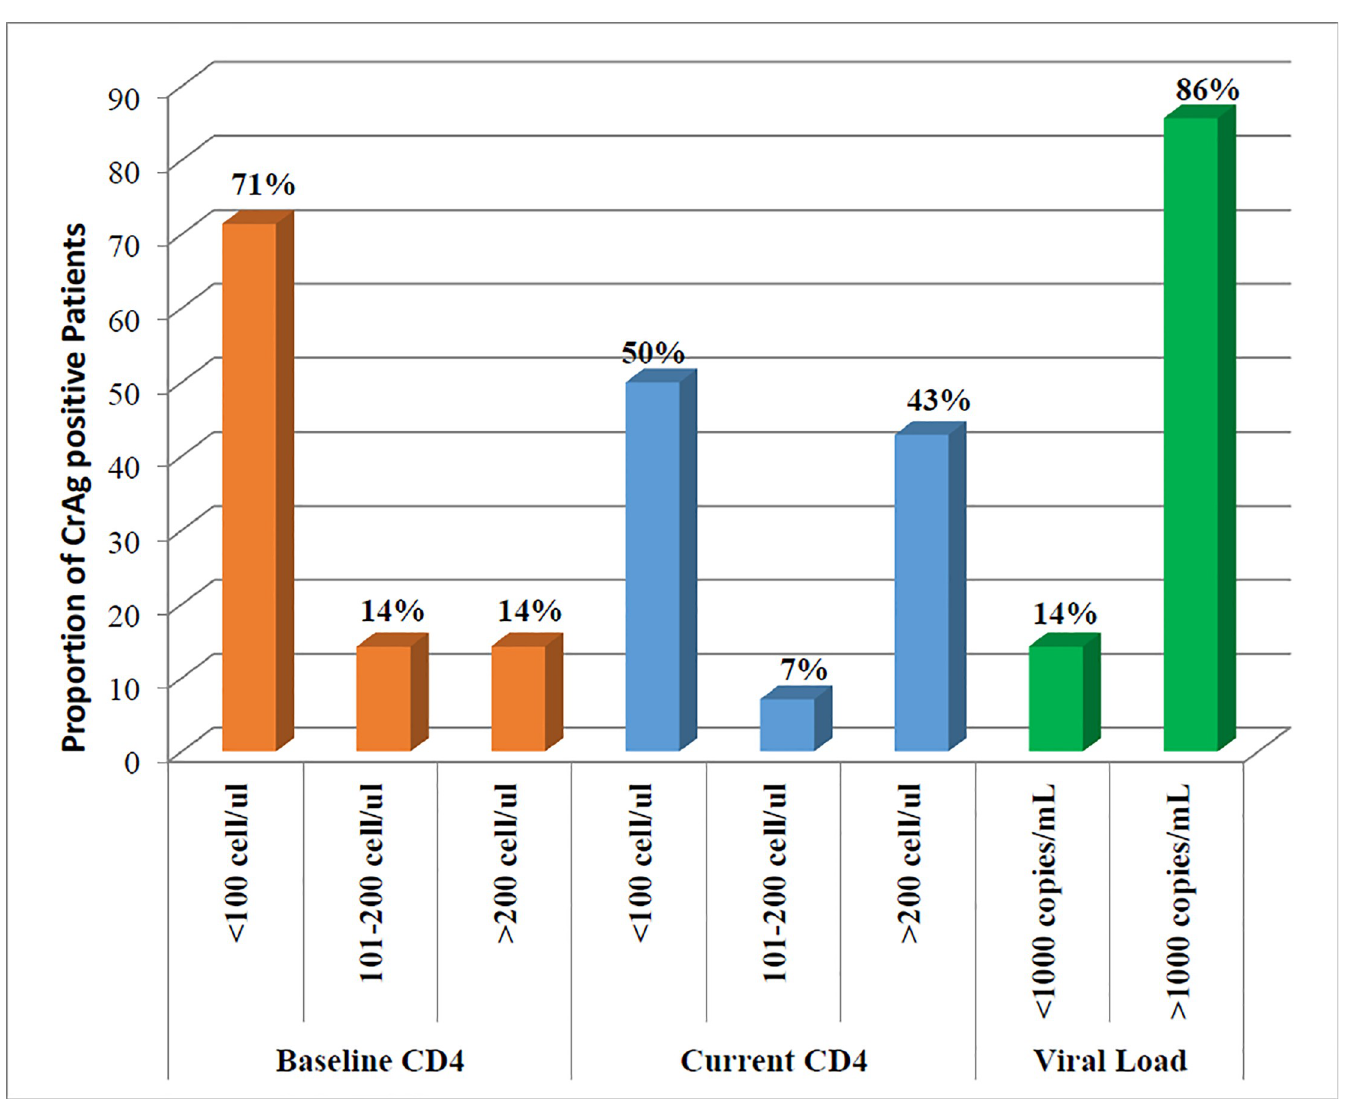
Fig 1. Baseline and current CD4+ T cell count, and viral load of CrAg positive HIV/AIDS patients on 2 nd line ART at two western Oromia hospitals, Ethiopia.